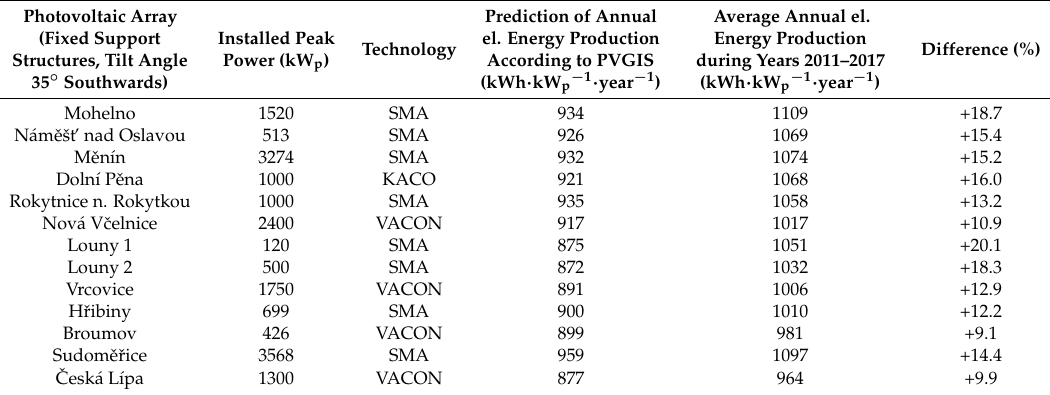
Table 1. Comparison between predicted and actual values of generated electric energy from selected photovoltaic arrays in the Czech Republic.